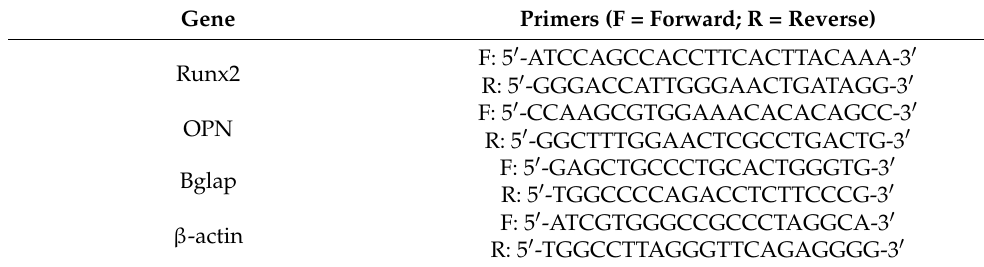
Table 3. Primer sequences used for qRT-PCR.